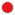
Self-assembly in PBS of chemically synthesized HTT exon1 analogs.A. Raw FCS time-dependent fluorescence fluctuations of HTTNTQ23P10C*K2 (red) and HTTNTQ37P10C*K2 (black). B. Autocorrelation functions for the 10 mins FCS data shown in A, with the data points as filled squares and solid lines representing the fits (see Materials and Methods) and the same color scheme as A. Lines below the graph show the residuals between the data points and the fit curve. C. Concentration dependence of molecular size estimated from diffusion times for HTTNTQ37P10C*K2 (■) and HTTNTQ23P10C*K2 (●). D. EM detail of different time points from the PBS incubation of a mixture of 2.0 μM HTTNTQ37P10K2. (More EM data is shown in S1 Fig.)